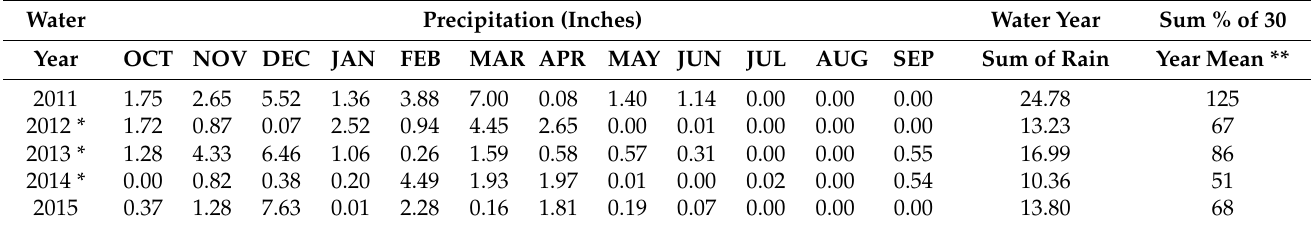
Table 3. Monthly precipitation summary data for water years 2011–2015 for long-term National Weather Service (NWS) precipitation station SACRAMENTO 5 ESE. Station location (Lat: 38°33 ′ N Lon: 121°25 ′ W) is approximately five miles east south east of downtown Sacramento.